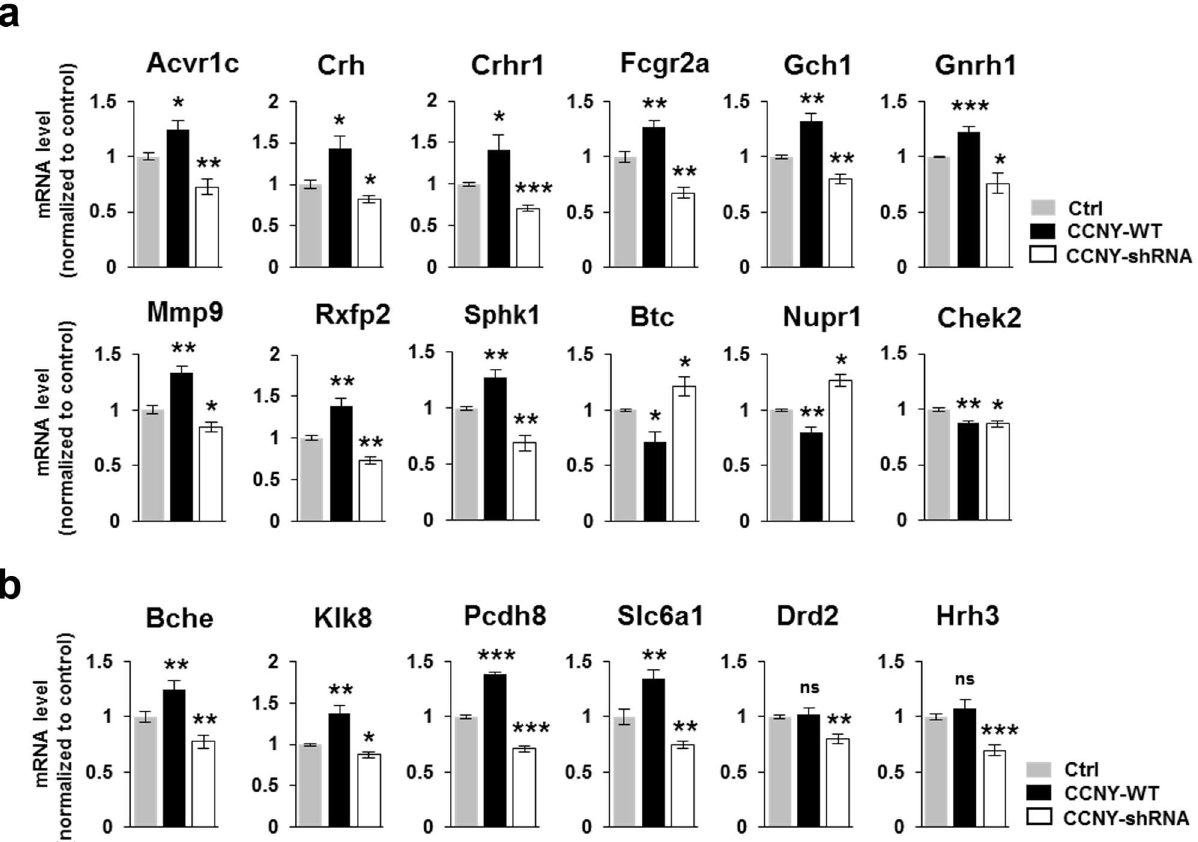
Fig 3. CCNY affectsthe biological processesrelated to apoptosis, and learning or memory in hippocampal neurons. ( a , b ) Validationof several genesin GO terms regulatedby CCNY. qRT-PCR validations of severalgenesbelongingto the term “(positive) regulationof apoptosis”in up-regulated GO terms by CCNY overexpression or down-regulatedGO terms by CCNY knockdown ( a ), the term “learningor memory” in down-regulatedGO terms by CCNY knockdown and the term “regulationof synaptic plasticity” in down-regulated GO terms by CCNY knockdown ( b ). Refer the S1